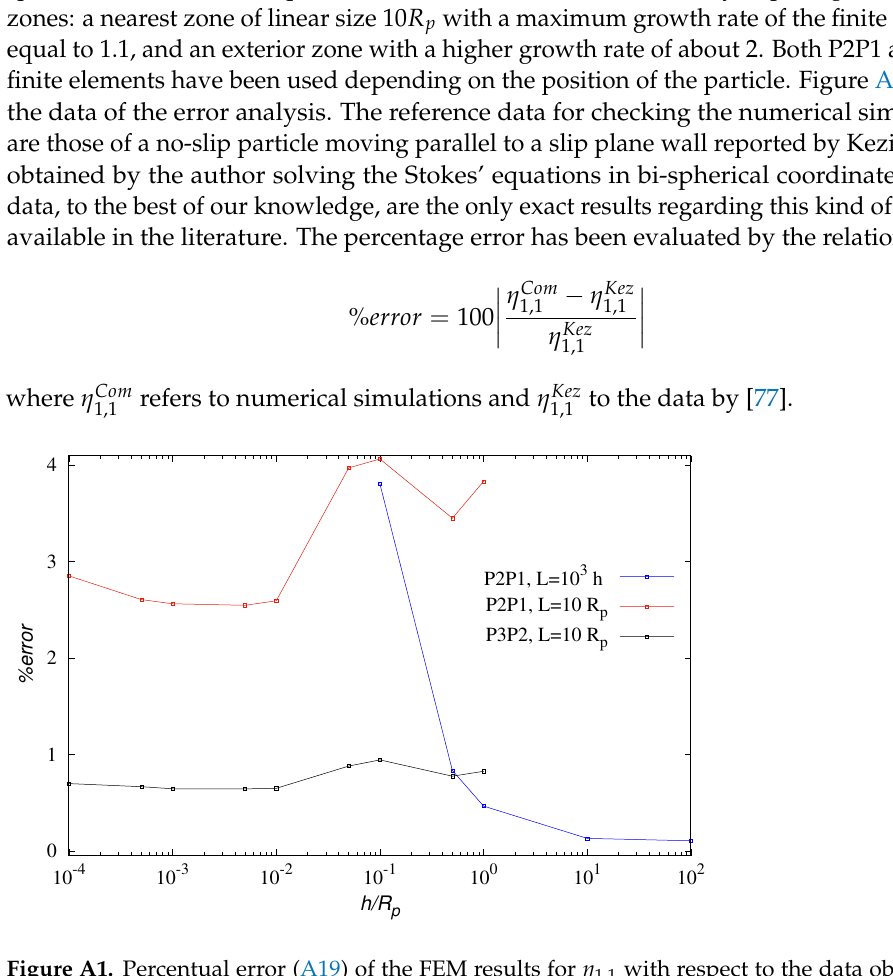
Figure A1. Percentual error (A19) of the FEM results for η 1,1 with respect to the data obtained by Kezirian [77] for a no-slip sphere translating parallel to a planar wall with slip length λ w / R p = 10 4